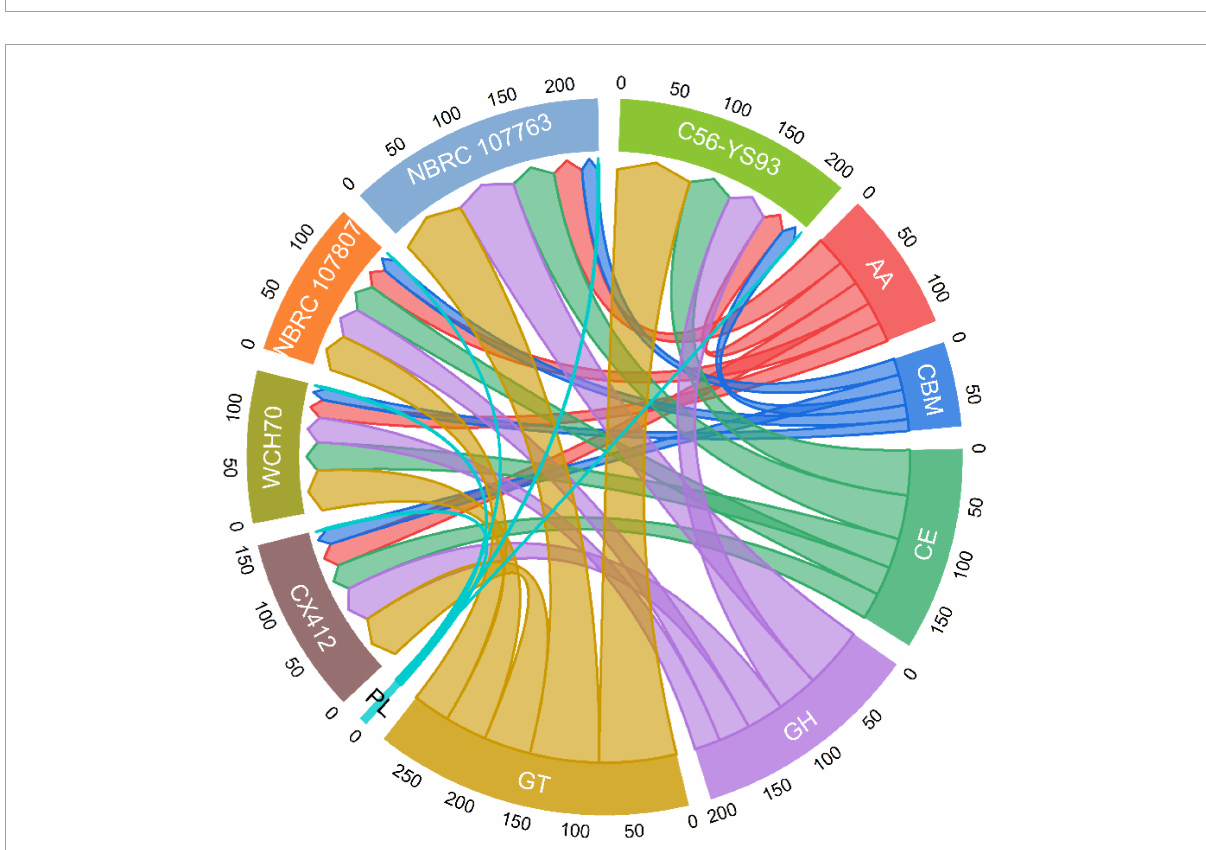
FIGURE5 Carbohydrate-Active Enzymes (CAZymes). CAZymes classification result: AA, Auxiliary Activities; CBM, Carbohydrate-Binding Modules; CE, Carbohydrate Esterases; GH, Glycoside Hydrolases; GT, Glycosyl Transferases; PL, Polysaccharide Lyase; CX412, Geobacillus sp. CX412; WCH70, Geobacillus sp. WCH70; 107807, Parageobacillus toebii NBRC 107807; 107763, Parageobacillus thermoglucosidasius NBRC 107763; C56-YS93, Parageobacillus thermoglucosidasius